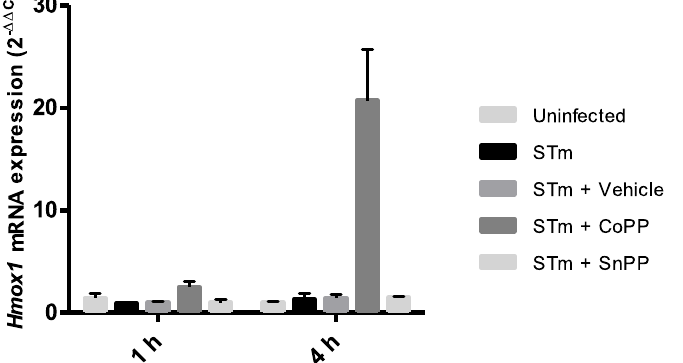
Figure A3. Relative expression of hmox1 in RAW264.7-infected cells treated with Hmox1 modulating drugs. RAW264.7 cells were infected with S. Typhimurium MOI 25 for 1 h, treated with 100 µg/mL gentamicin for 1 h and then treated with either vehicle (0.75 mM NaOH), CoPP 50 µM, SnPP 50 µM for 1 and 4 h.